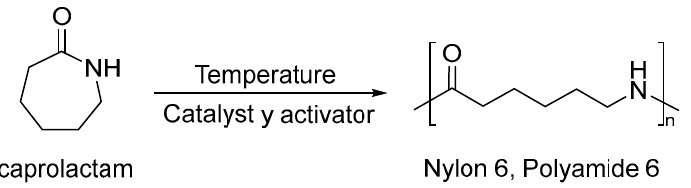
Figure 14. Synthesis of the anionic polymerization of PA-6.